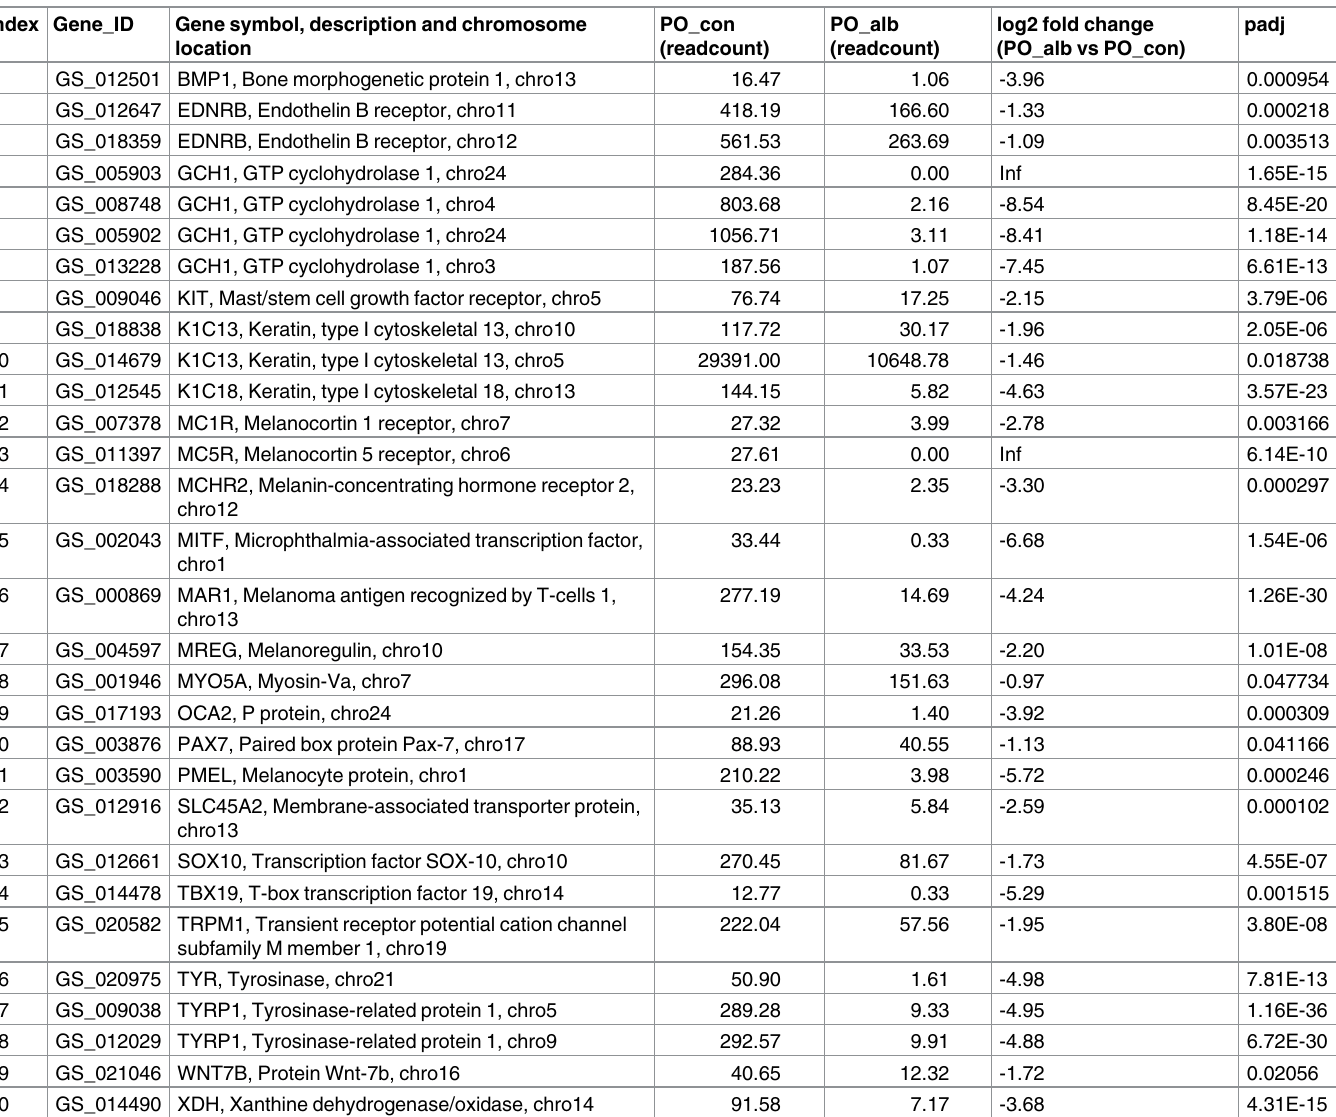
Table 1. The overlapped pigmentation related genes between previous study and present